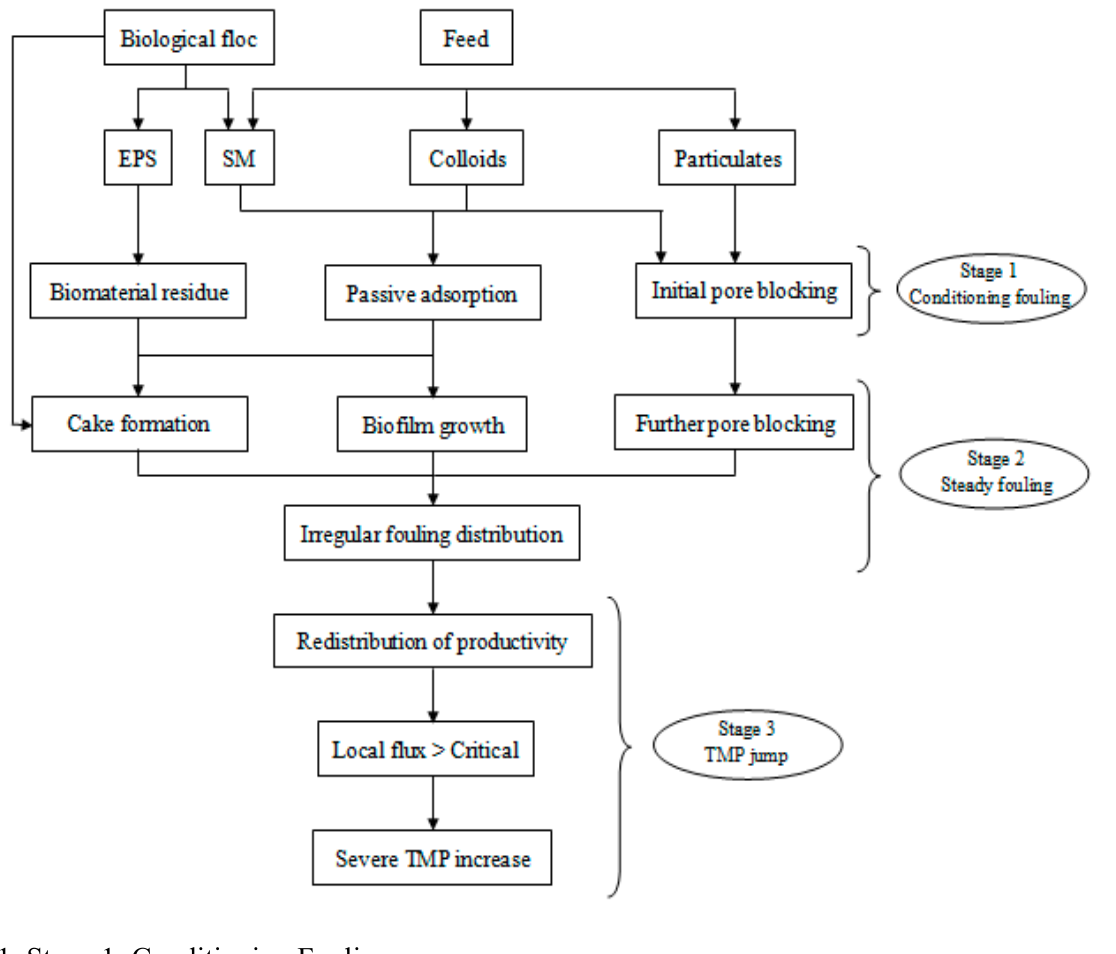
Figure 2. Membrane Bioreactors (MBR) fouling mechanisms for operation at constant flux. Reproduced with permission from Reference [10]. Copyright 2011